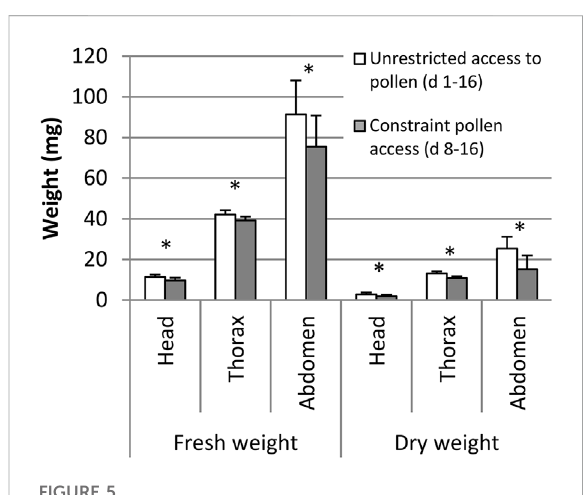
FIGURE 5 Freshanddryweightofhead,thorax,andabdomenofbeeswith unrestricted access to pollen (day 1 – 16) and constraint pollen access (day8 – 16).Meansandstandarddeviationsareshown: n =60(10bees out of 6 replicated cages). * indicates p < 0.05, Student ’ s t